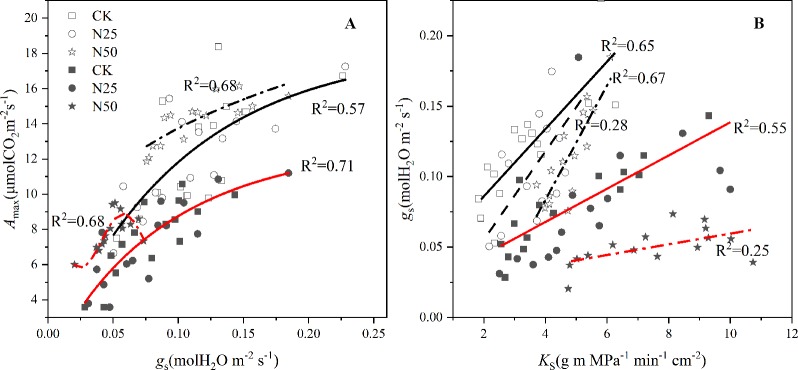

A
max as a function of mean g
s for H2O averaged over each light response curve and the K
S averaged from per tree supported g
s for H2O for Liquidambar formosana and Cyclobalanopsis glauca. Open and closed symbols represent L. formosana and C. glauca, respectively. p < 0.01 for linear regressions for each species and treatments. Solid lines fit linearly to CK and N25 data, dotted and broken lines fit linearly to N50 data, and the broken lines fit linearly to N25 data for C. glauca in the right Figure. Panel A: Amax as a function of mean gs, Panel B: gs as a function of mean KS.